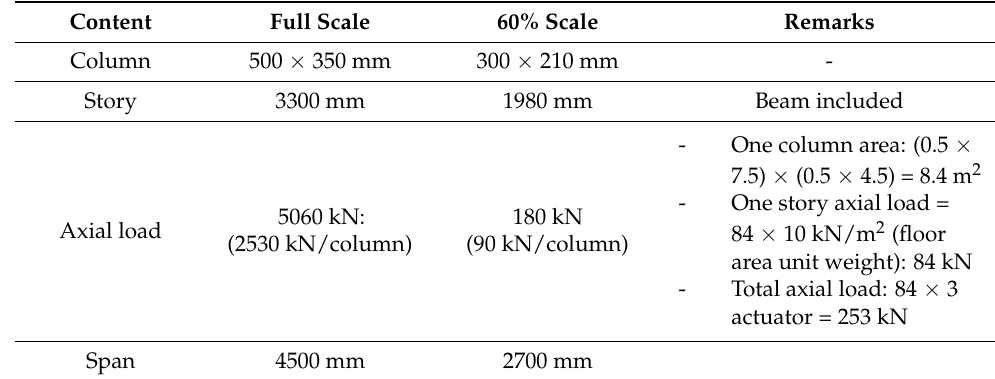
Table 1. Comparison of members between original frame and test